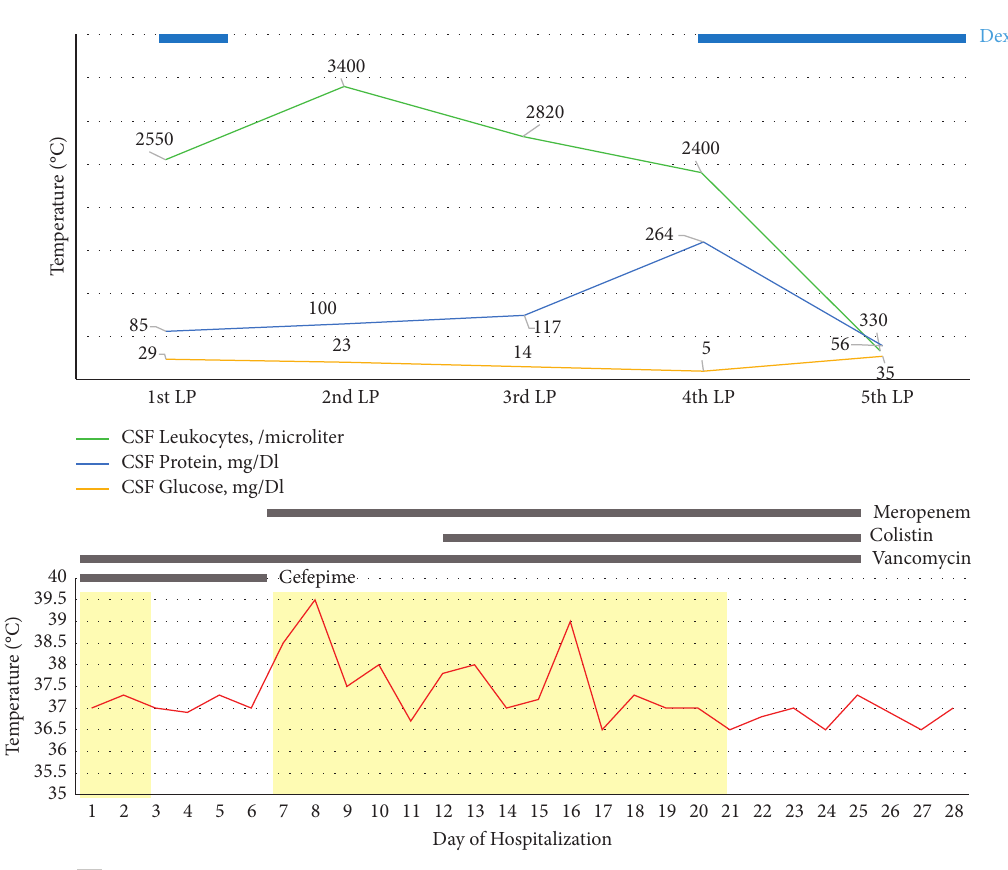
Figure 2: The changes of clinical and laboratory features of the patient and therapeutic regimens over (Figure 1). A turbid fluid was obtained after lumbar puncture. CSF analysis revealed marked polymorphonuclear pleocytosis of 2250/ μ L, increased protein level of 285 mg/dL, and decreased glucose level of 20 mg/dL. All microbiological